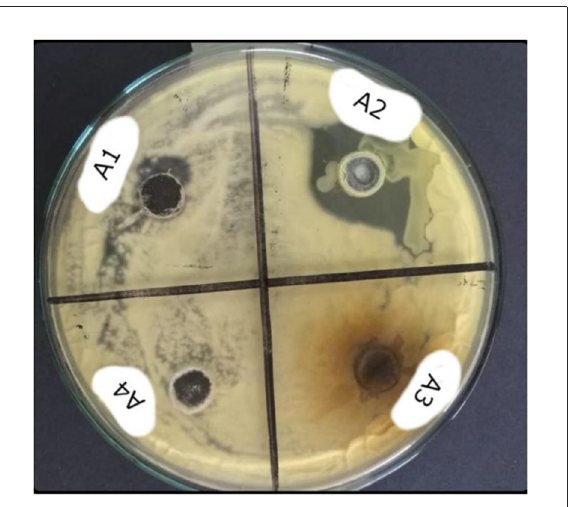
FIGURE6 Antifungal study of PANI/ZnO (A1), ZnO (A2) PANI/CuO NPs (A3), and CuO (A4) at 12 mmol L − 1